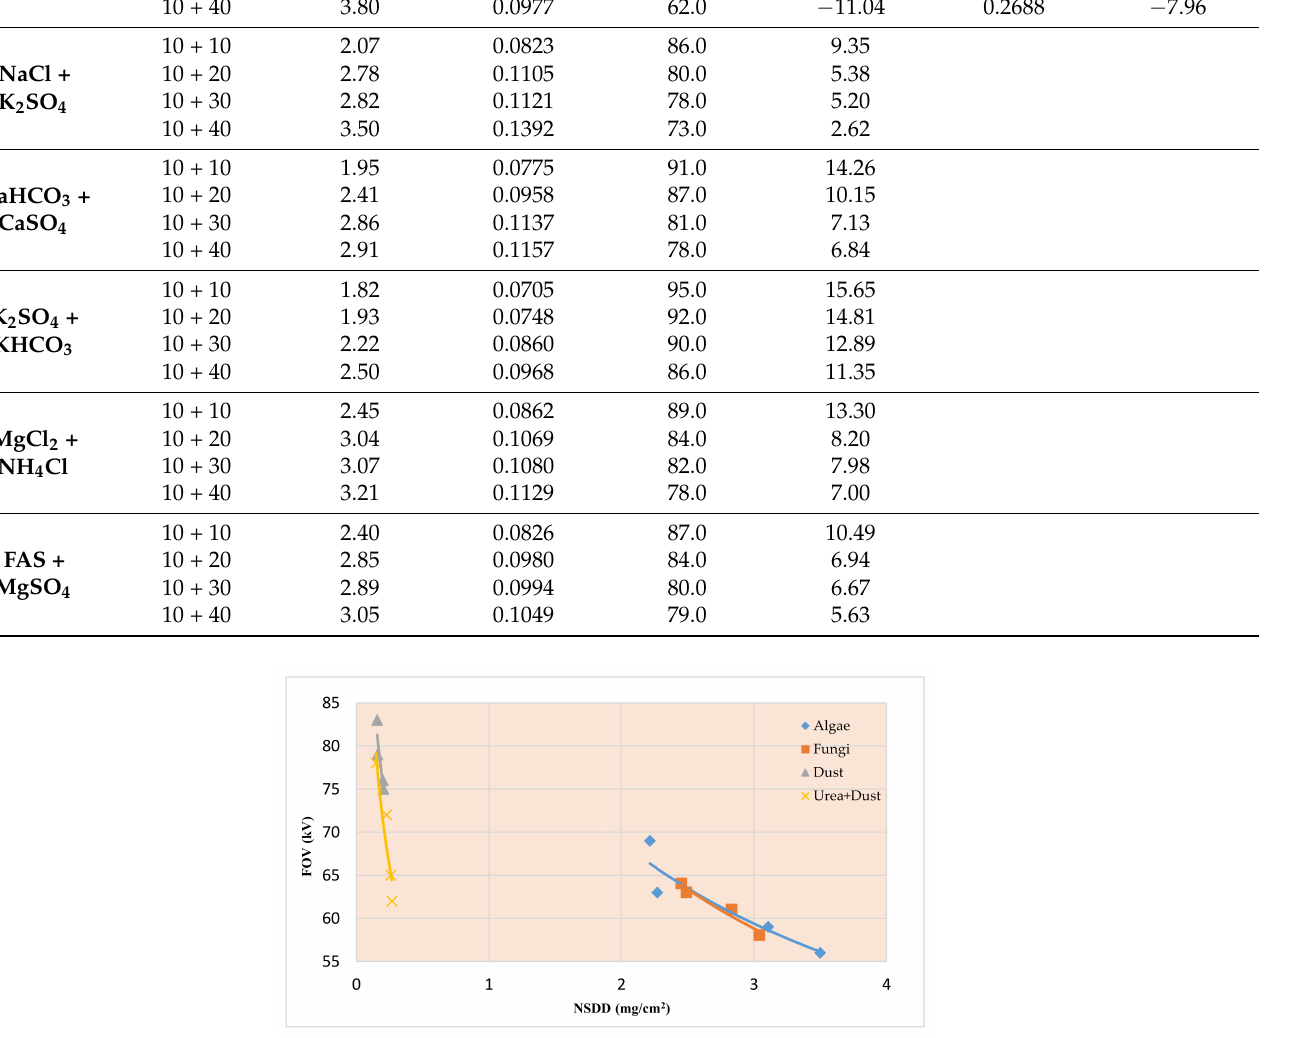
Figure 5. NSDD vs. FOV characteristics of the insulator contaminated with different partially soluble